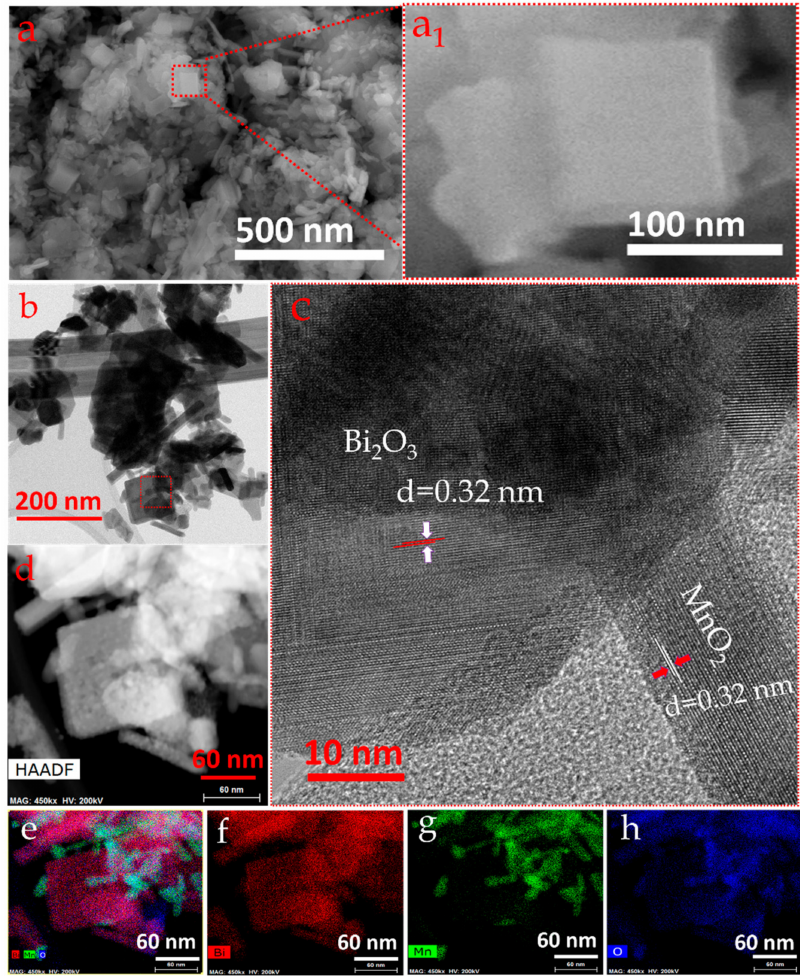
Figure 3. ( a ) Low-magnification field-emission scanning electron microscope (FE-SEM) image along with magnified image in the inset ( a 1 ), showing single faceted crystal. ( b ) Transmission electron microscopy (TEM) image and ( c ) high-resolution TEM (HRTEM) image from the marked square portion in Figure 3b. ( d ) high-angle annular dark field (HAADF) image. ( e – h ) EDX mapping images confirming the presence of Bi, O, and Mn